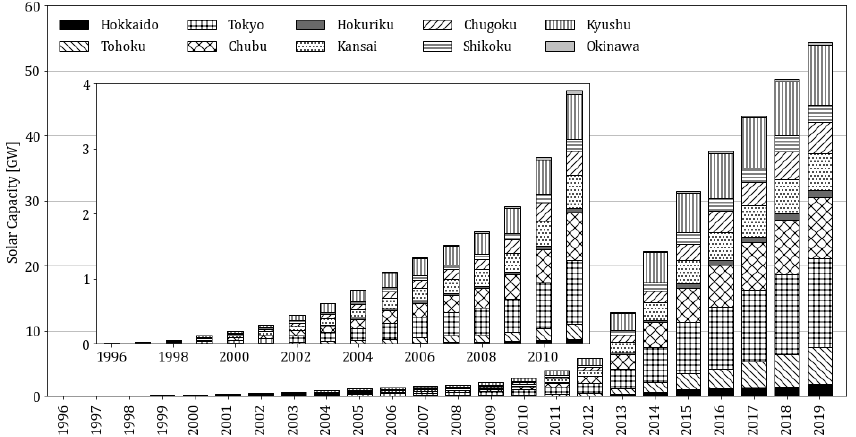
Figure 3. Development of installed solar PV capacity (GW) in Japan from 1996 to 2019 by electricity power companies’ regional service area.